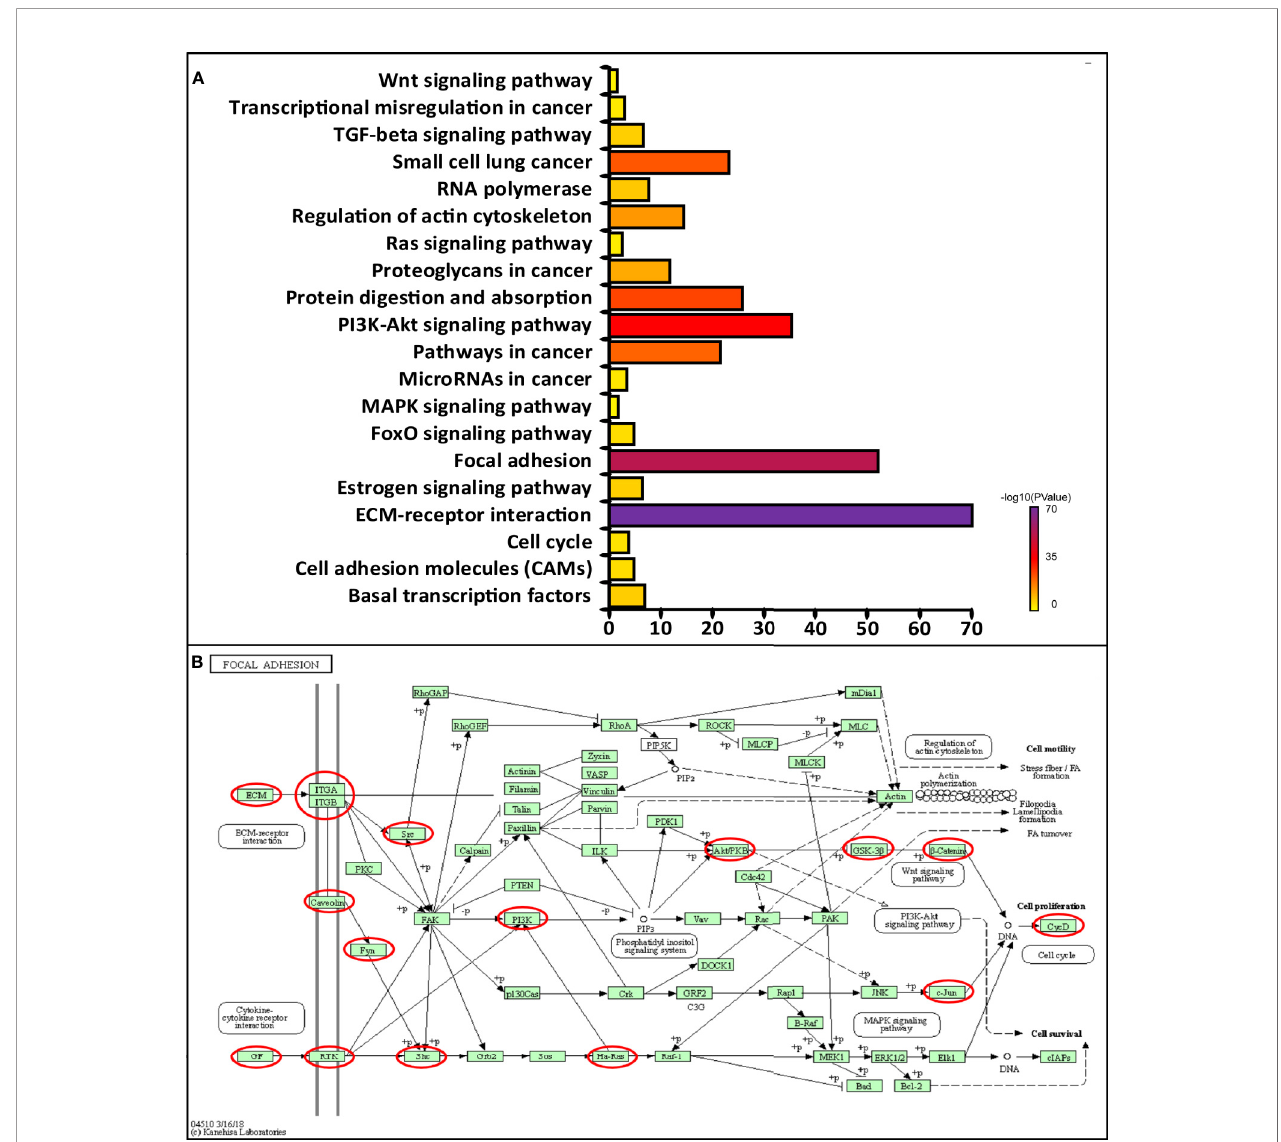
FIGURE 6 | (A) Molecular pathways associated with CAVs and CAVINs regulation implemented by DAVID tools. (B) Focal adhesion pathways regulated by CAVs and CAVINs in breast cancer.